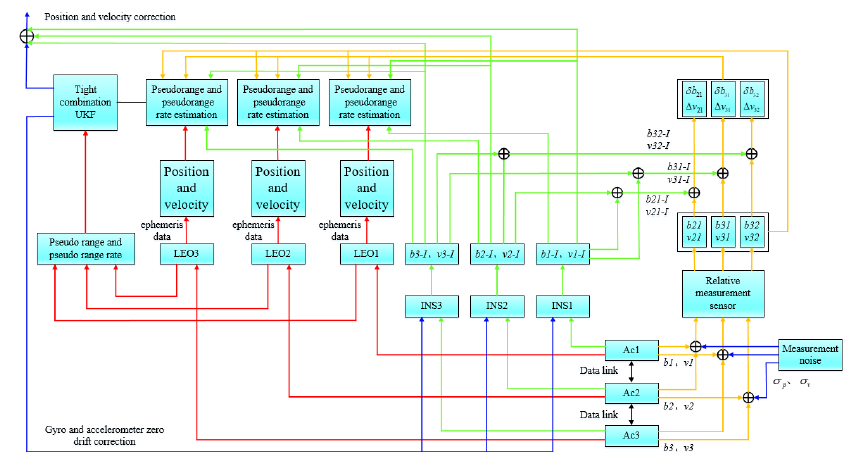
Figure 3. Overall block diagram of the system.